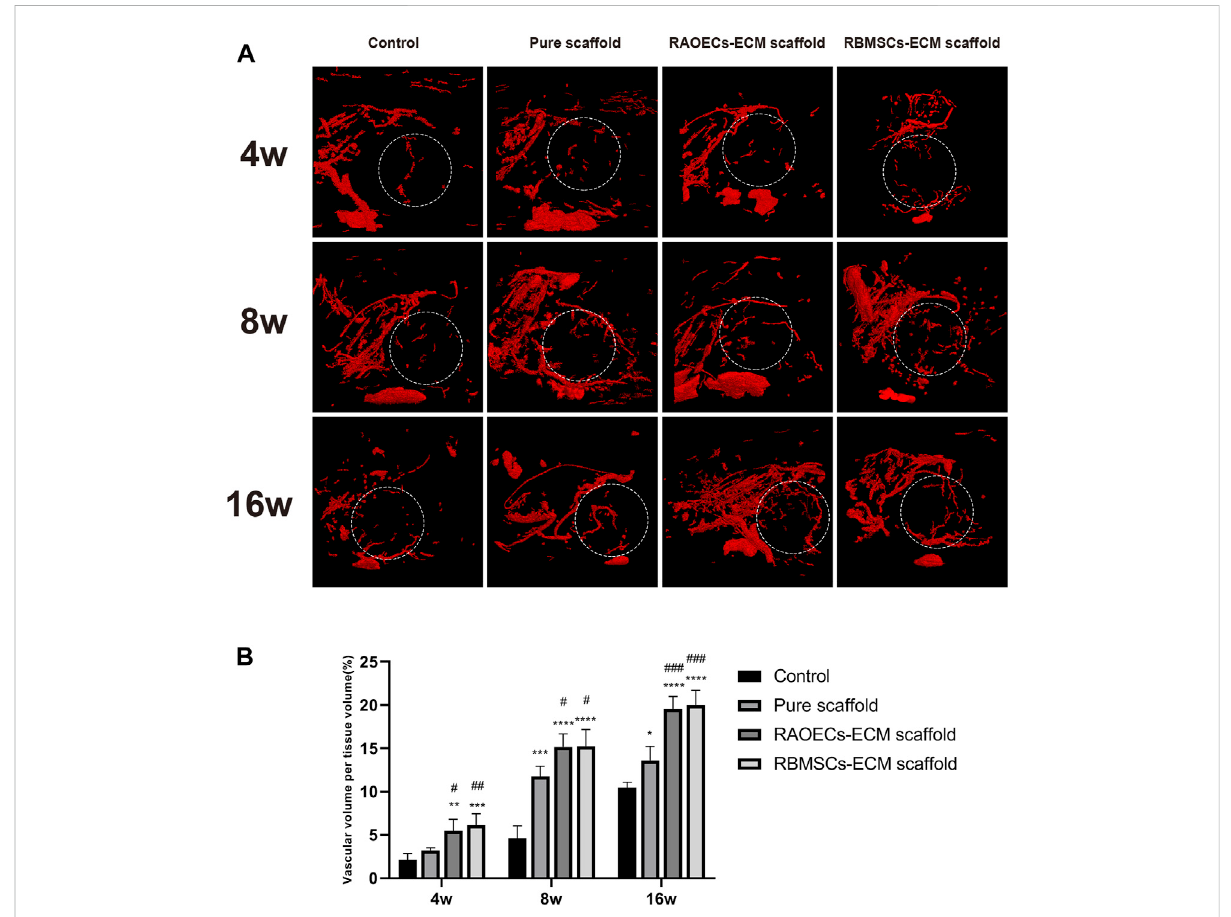
FIGURE 5 The vascular volume at different mandible defects was examined by Micro – CT at 4, 8, and 16 weeks after the operation. (A) 3D – reconstructed blood vessel images. (B) Quantitative analysis of vascular volume in the bone defect areas. (Signi fi cant effect compared to control group: p p <